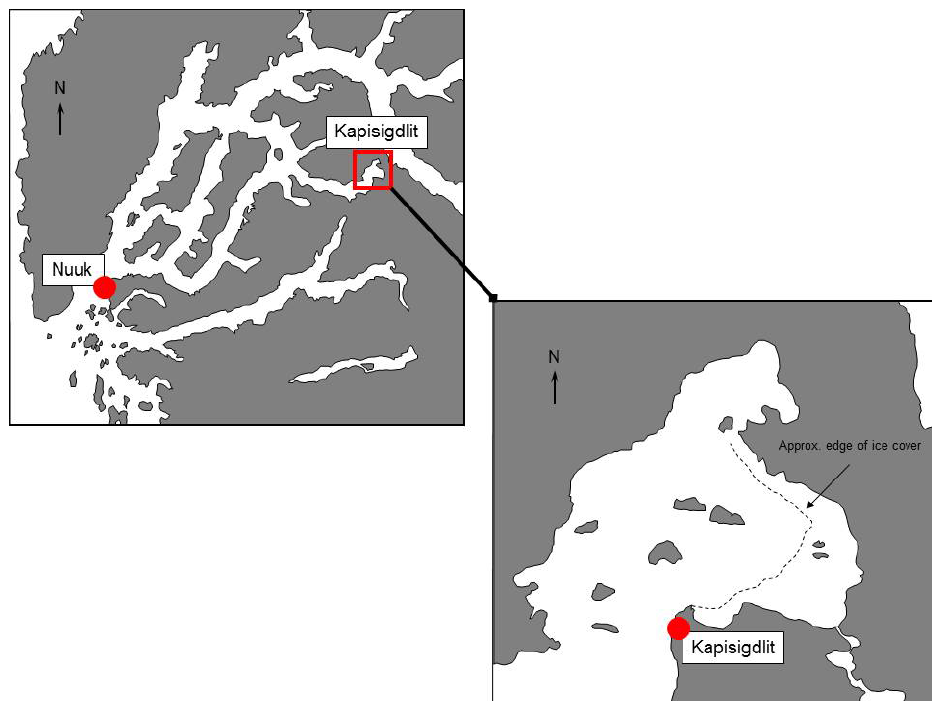
Fig. 2. Map showing the Nuuk fjord area in Greenland and the location of the field site near the town of Kapisigdlit (64 ◦ 26 0 10 00 N, 50 ◦ 16 0 10 00